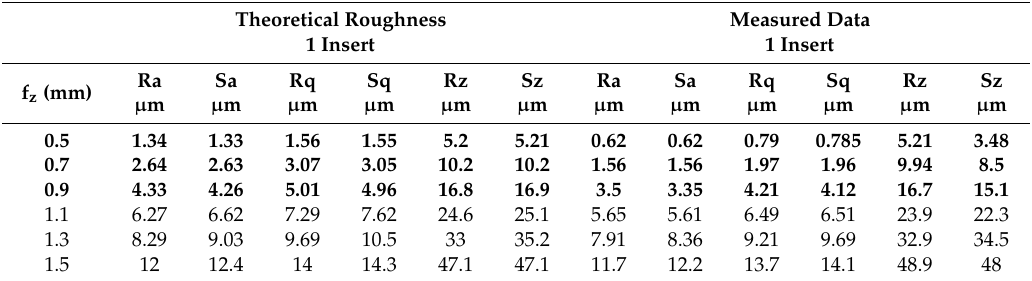
Figure 5. Milled 2D profiles ( a ) and 3D surfaces ( b ) when four inserts were applied. Table 3. Roughness values on surfaces milled by a single insert.